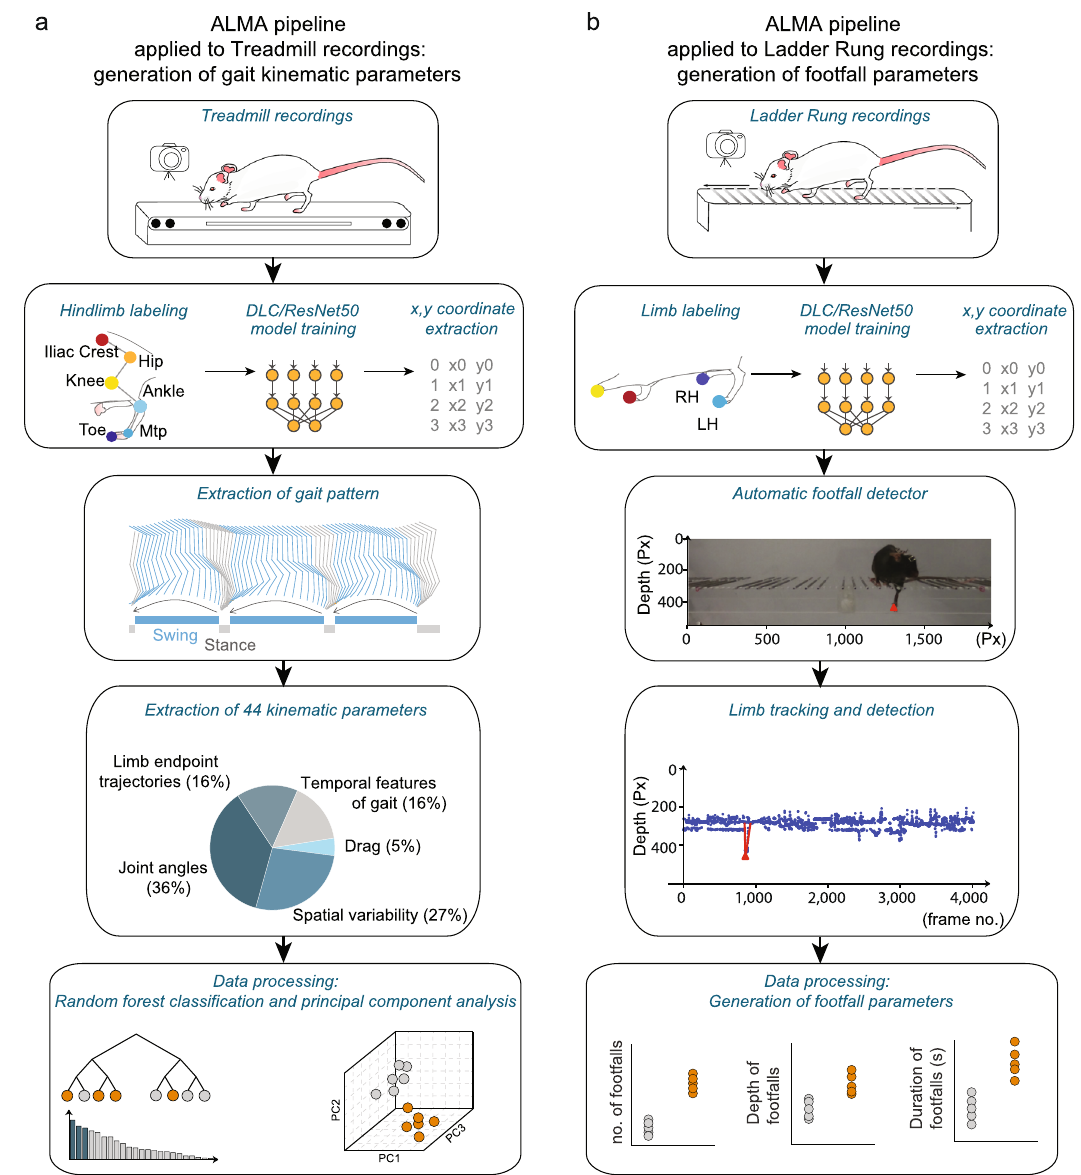
Fig. 1 Automated behavioral analysis using ALMA toolbox. a Schematic of ALMA toolbox application to treadmill recordings for the generation of gait kinematic parameters. First, treadmill videos were recorded with a GoPro 8 camera placed parallel to the treadmill. Then, markerless limb labeling and modeling was trained and re fi ned using ResNet-50 and DeepLabCut (DLC) and coordinates were extracted. Coordinates were tracked for six hindlimb joints (toe, metatarsophalangeal (MTP) joint, ankle, knee, hip, and iliac crest) in the treadmill kinematic paradigm, and the coordinates were processed using the toolbox to generate hindlimb trajectories. This allowed the generation of 44 kinematic parameters that represented joint angles, spatial variability, limb endpoint trajectories, temporal features of gait, and dragging. Data processing was conducted in ALMA to obtain principal component analysis and random forest classi fi cation of the parameters. b Schematic of ALMA toolbox application to the ladder rung recordings for the generation of footfall parameters. First, ladder rung videos were recorded with a GoPro 8 camera placed parallel to the ladder. Then, markerless limb labeling and modeling was trained and re fi ned using ResNet-50 and DLC, and coordinates were extracted. Coordinates could be tracked for all four paws. The toolbox used the automated footfall detector to extract limb tracing and footfall detection. The on- and off-set of locomotor errors (footfalls) were estimated using signal processing methods and subjected to manual validation. Three parameters, the number, depth, and duration of the footfalls, were extracted. Px